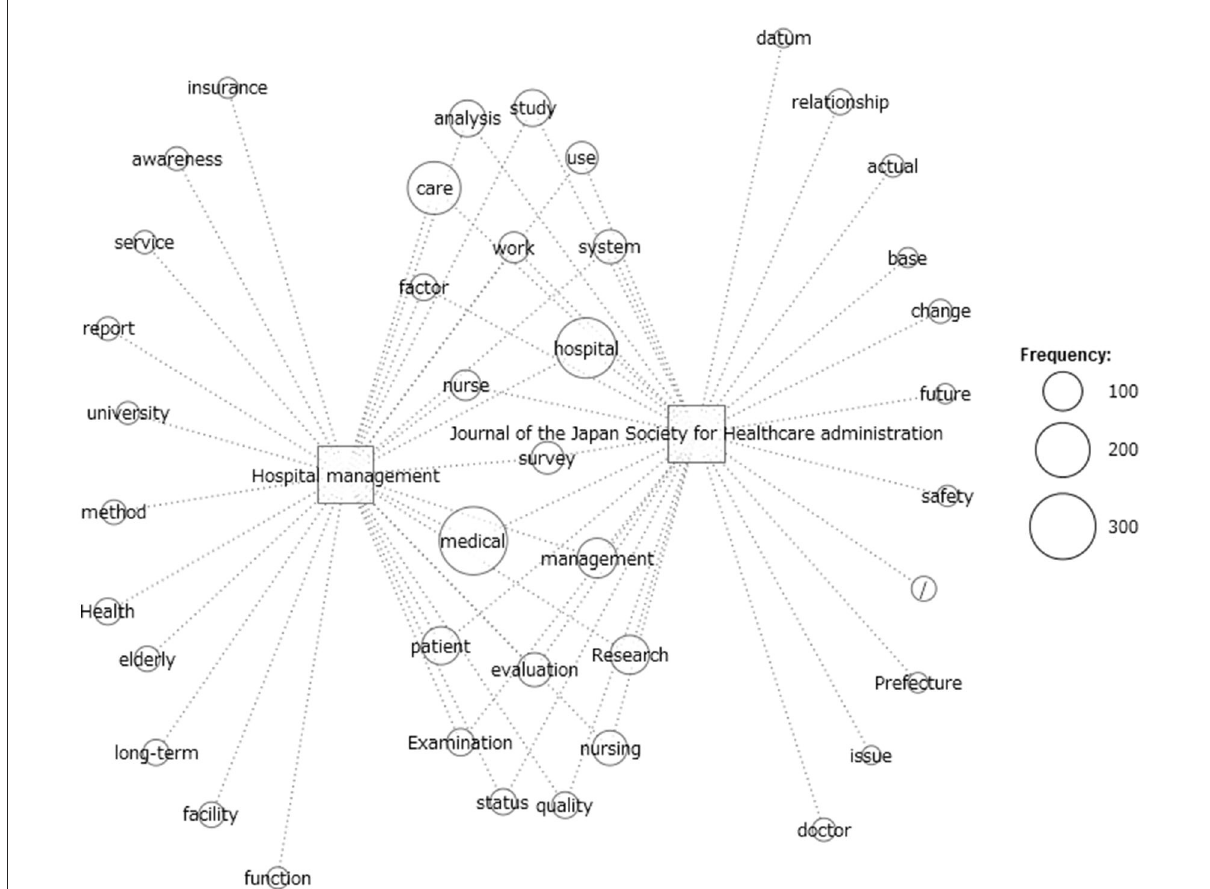
FIGURE1 Co-occurrence network analysis of the extracted